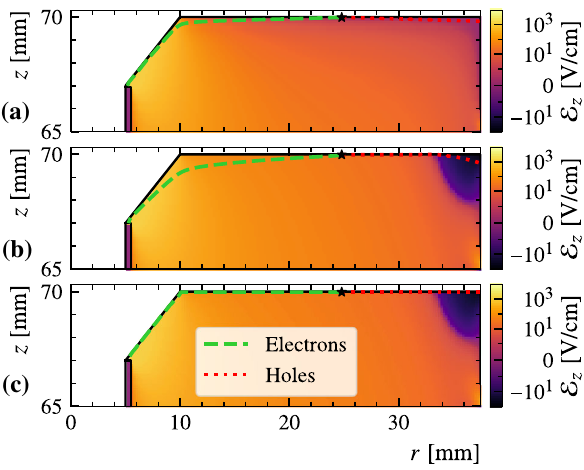
Fig. 16 The z -component of the electric field, E z , in the top part of Super-Siegfried.Thedashed(dotted)linesarethedrifttrajectoriesofthe electrons (holes) of an event simulated at r = 24 . 8mm and ϕ = 135 . 6 ◦ corresponding to one measurement position of the scan RSF marked by the star. In a , thefieldsimulationislimitedtothevolume of the detector. In b and c , the field simulation includes the infrared shield and detector base plate of GALATEA. In c , the drift model is modified, forcing